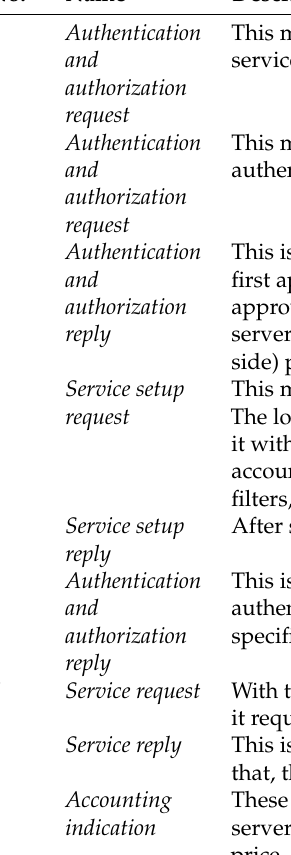
Table 2. Main signaling messages of the agent authorization